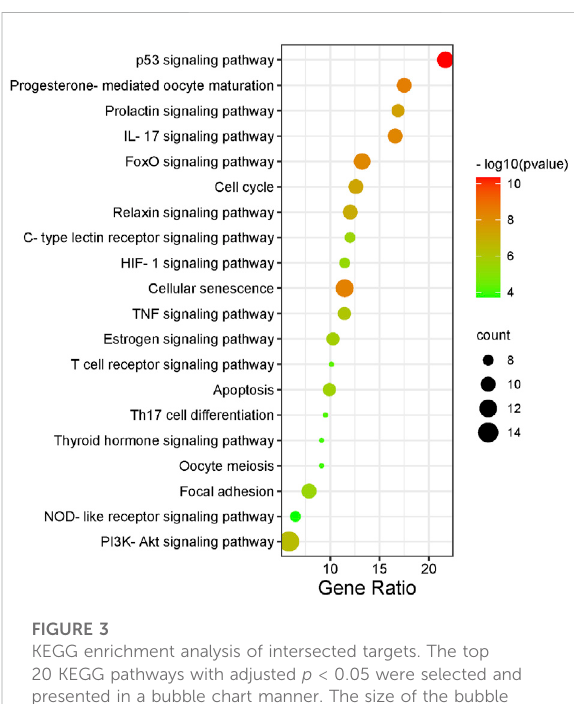
FIGURE 3 KEGG enrichment analysis of intersected targets. The top 20 KEGG pathways with adjusted p < 0.05 were selected and presented in a bubble chart manner. The size of the bubble represents the number of targets enriched in the indicated pathway and the color of the bubble represents the p value of